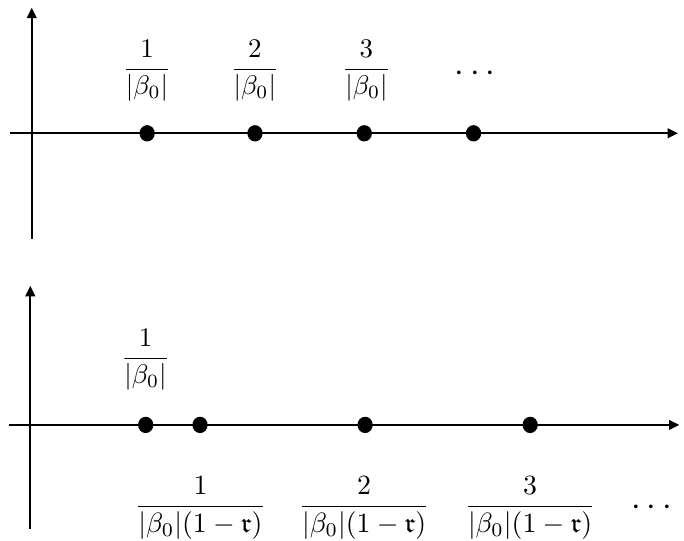
Figure 1 . The figure at the top shows the traditional picture of IR renormalon singularities in asymptotically free theories, corresponding to (1.1) with an even value of ‘ . The figure at the bottom shows the actual singularities that are found for the free energy of the Gross-Neveu model and the principal chiral field, where the correction r is given in (1.4), (1.5),